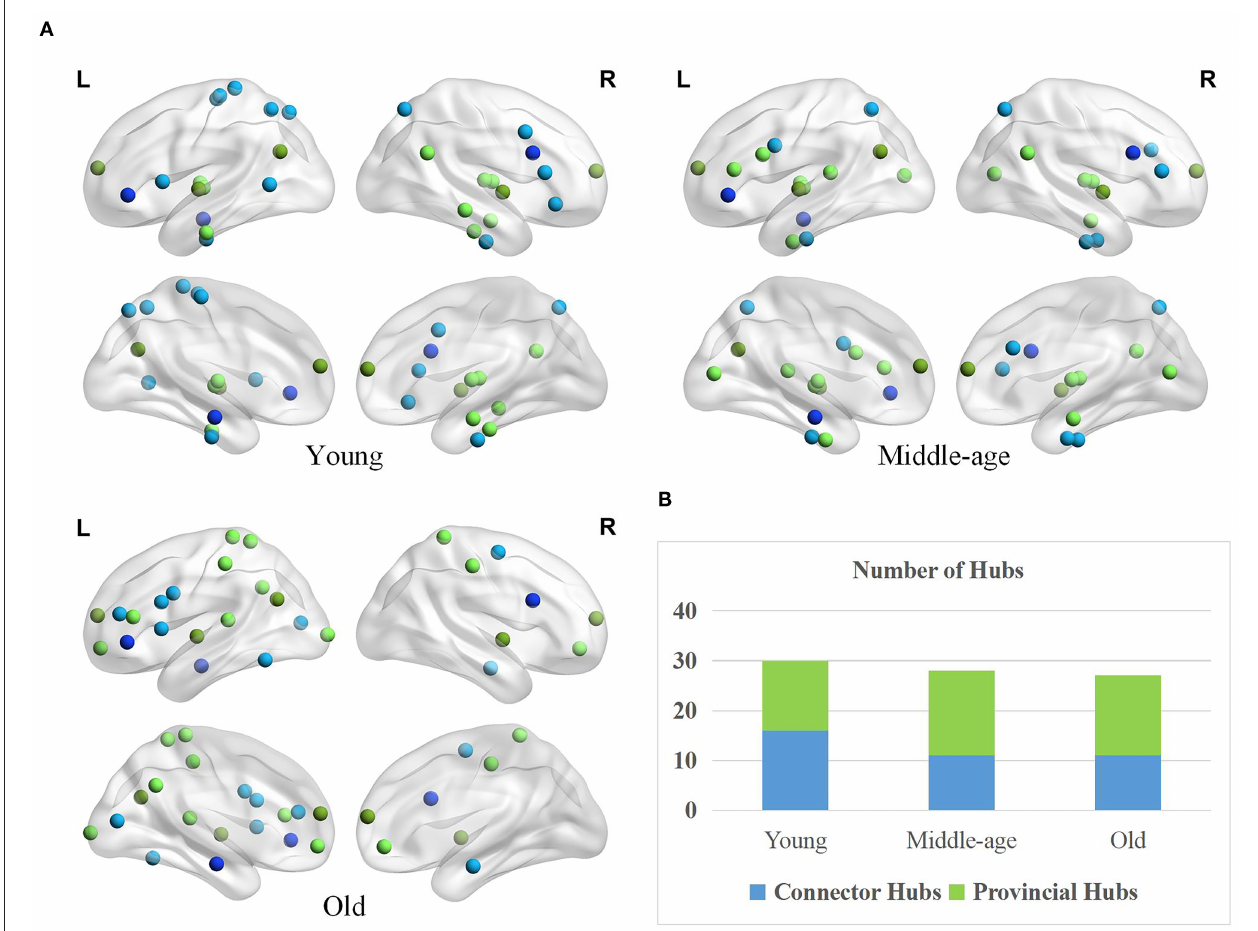
FIGURE 5 | Age-associated differences in spatial distribution and the number of two types of hubs. (A) Spatial distributions of provincial (green) and connector hubs (blue) across three age groups. The darker color indicates the hubs remaining in the three groups and the lighter color represents the hubs that are unique to the specific group. (B) The number of provincial and connector hubs in three age